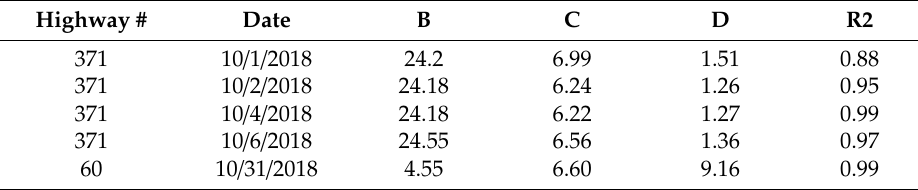
Table 3. Asphalt specimen HD model-generated dielectric to air void prediction coe ffi cients and goodness of